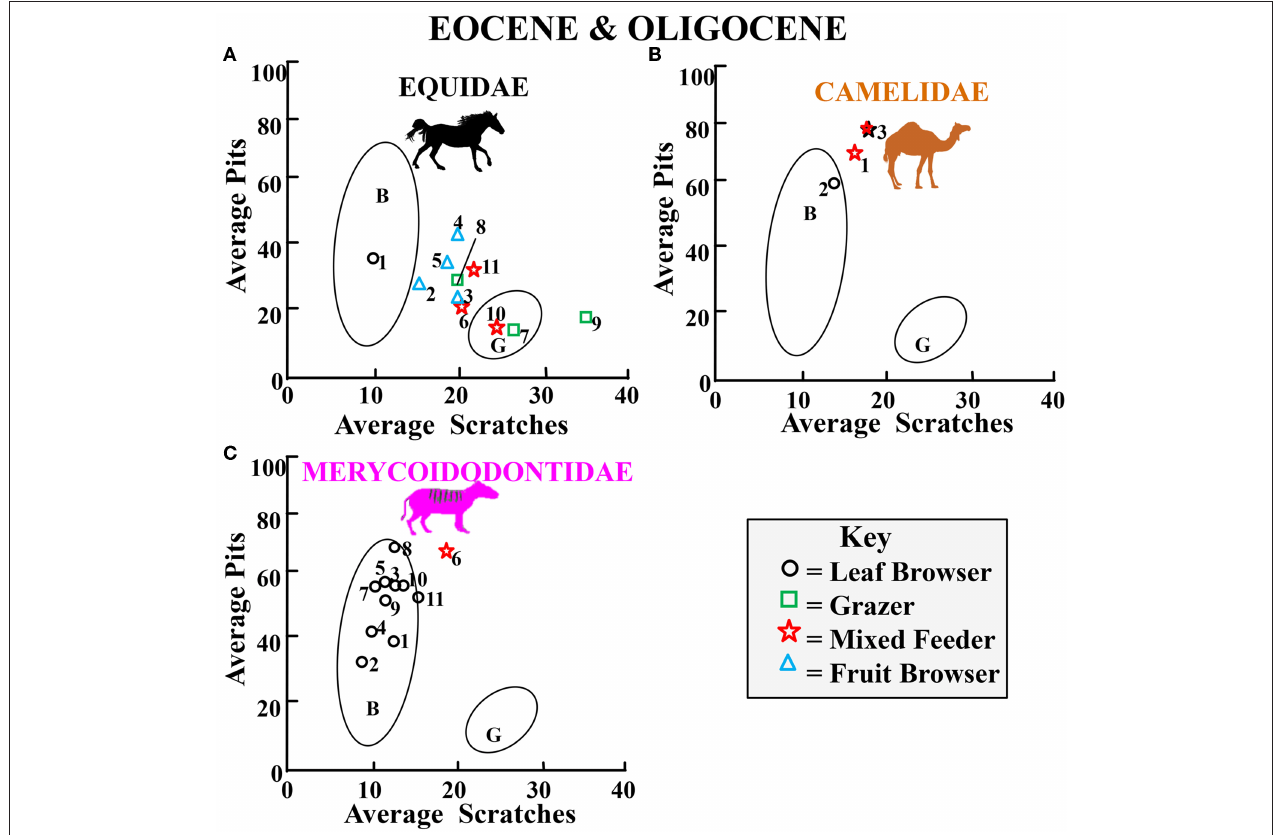
FIGURE 9 | Bivariate plot showing results for the average number of pits vs. the average number of scratches per taxon for Eocene and Oligocene fossil equids (A) , camelids (B) , and merycoidodontids (C) plotted in reference to extant leaf dominated ungulate browsers (B), and extant grazers (G) at 35 times magnification (extant comparative data from Semprebon, 2002 and Solounias and Semprebon, 2002). Gaussian confidence ellipses ( p = 0.95) on the centroid are indicated for the extant leaf browsers and grazers (convex hulls) adjusted by sample size. Key to Equidae: (as in Figures 3 , 4 ) Semprebon et al. (2016) − 1 = Species A, 2 = Species B, 3 = Species C, 4 = Species D, 5 = Species E, 6 = Mesohippus sp., 7 = Miohippus obliquidens , 8 = Mesohippus bairdii , 9 = Mesohippus sp., 10 = Mesohippus westoni , 11 = Mesohippus sp.. Key to Camelidae: 1,2 = Poebrotherium sp., 3 = Poebrotherium wilsoni . Key to Merycoidodontidae: 1 = Orenetes gracilis chadronensis , 2 = Merycoidodon culbertsoni , 3 = Merycoidodon bullatus , 4 = Orenetes gracilis , 5 = Merycoidodon major , 6 = Leptauchenia decora , 7 = Sepsia nitida , 8 = Leptauchenia major , 9 = Eporeodon occidentalis , 10 = Merycochoerus superbus superbus , 11 = Merycochoerus superbus